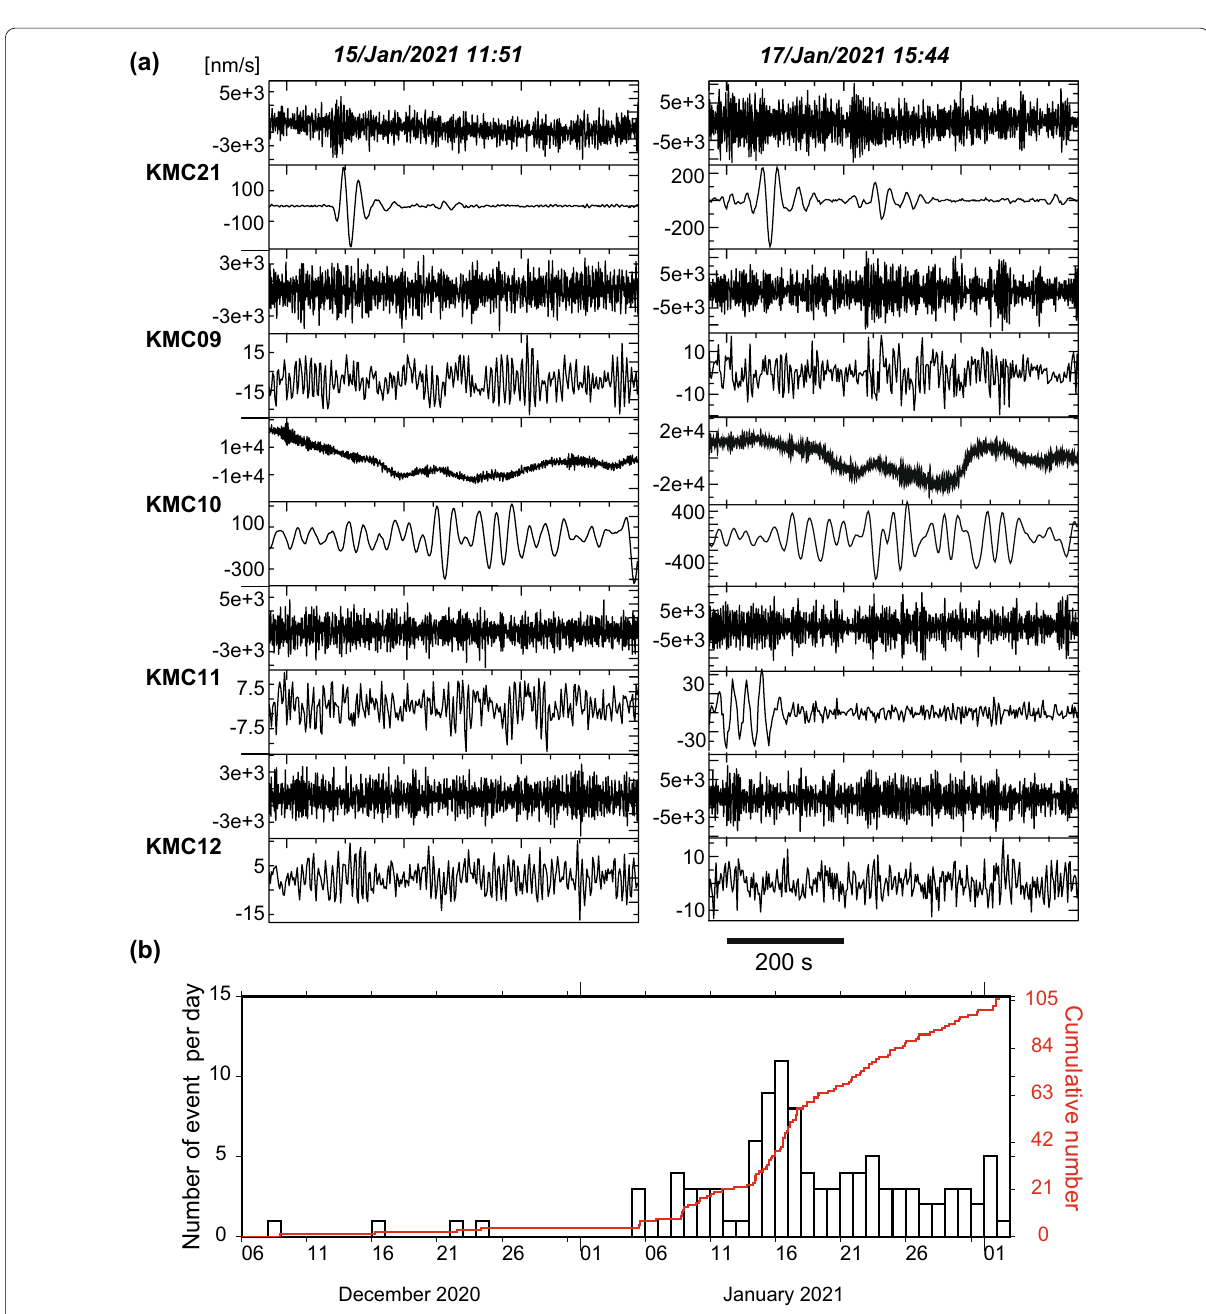
Fig. 5 sVLFE-like activity closes to the trough axis. a Examples of the observed waveform at Node C. For each station, the upper panel shows the original velocity waveform reduced to the trend, and the lower panel shows the band-pass-filtered (between 0.03 and 0.05 Hz) velocity waveforms (see details in text). The waveform at the KMC10 station has larger noise than those at other stations as this station is not buried beneath the seafloor. b Histogram of the sVLFE-like waveforms observed at